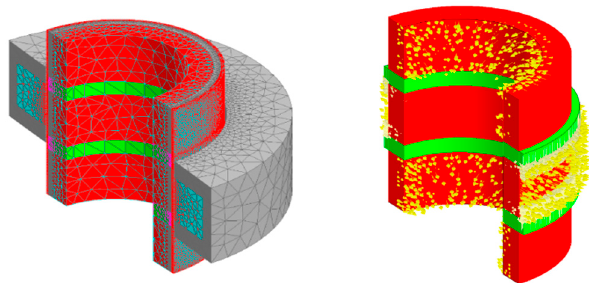
/ 8 model with a skewing angle of 75 ◦ .